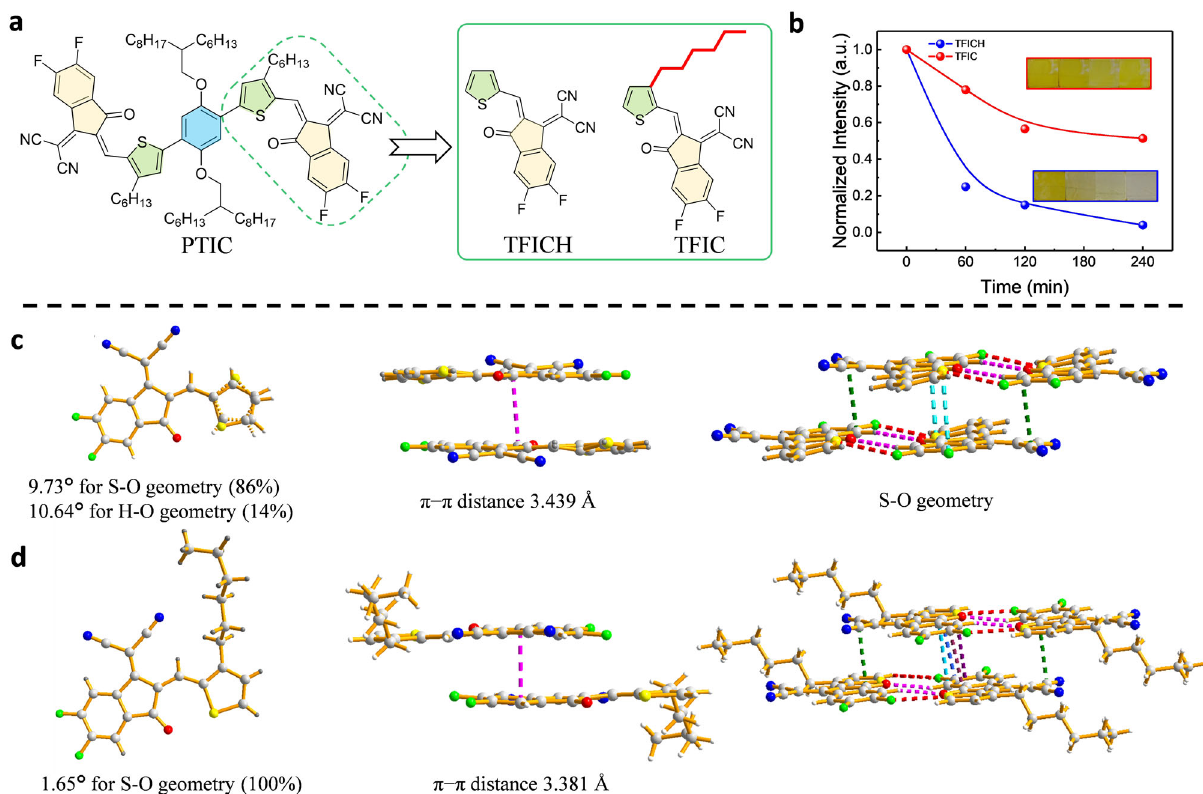
Fig. 5 The photostability and single-crystal analysis of model compounds. a Molecule structures of terminal models, TFICH, and TFIC from PTIC. b UV – vis absorption spectra and photo images of TFICH and TFIC fi lms under continuous illumination. Single-crystal structure of c , TFICH and d ,